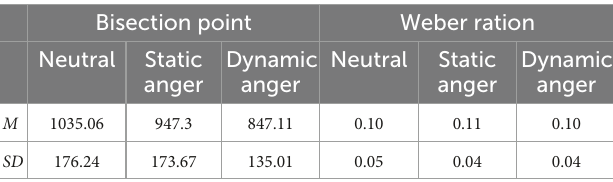
TABLE 2 Bisection point and weber ratio for the three different facial expression